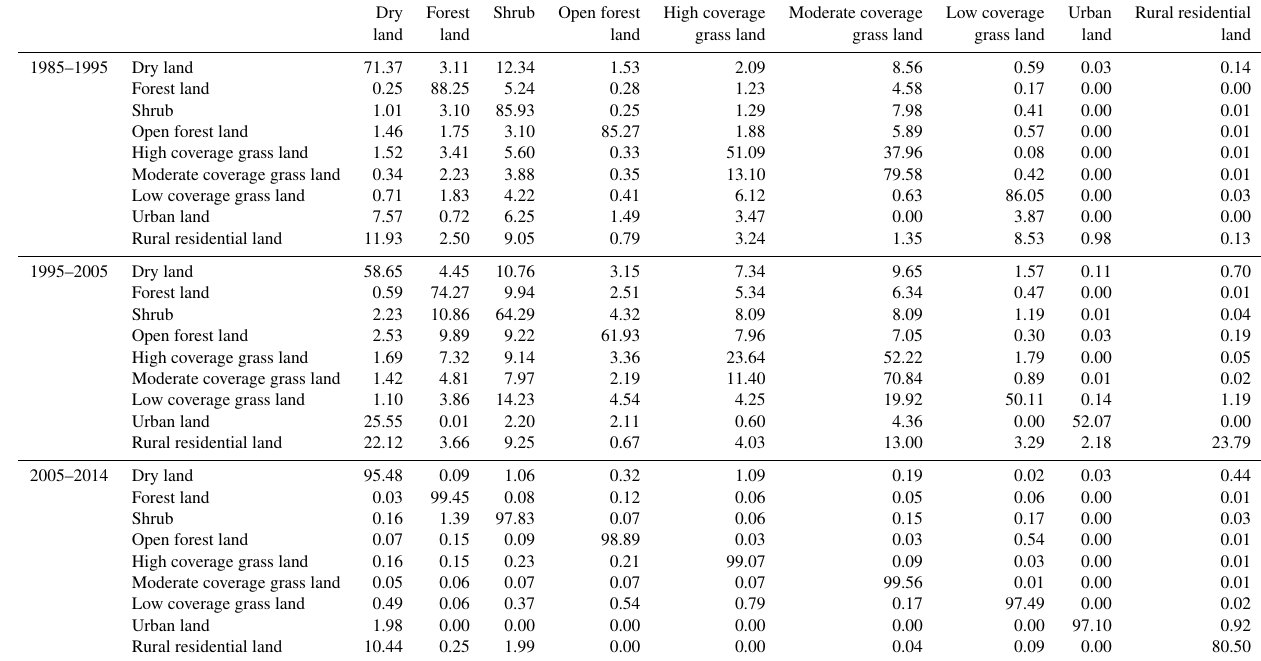
Table 2. Conversion matrixes for typical land use types from 1985 to 2014 (%).